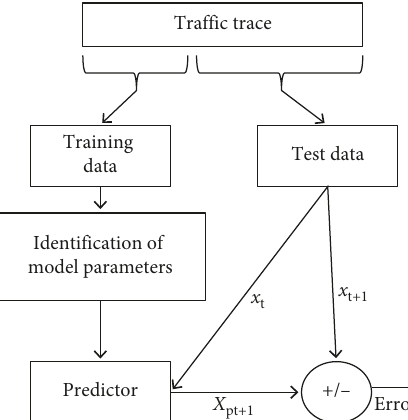
Figure 4: Prediction performance evaluation